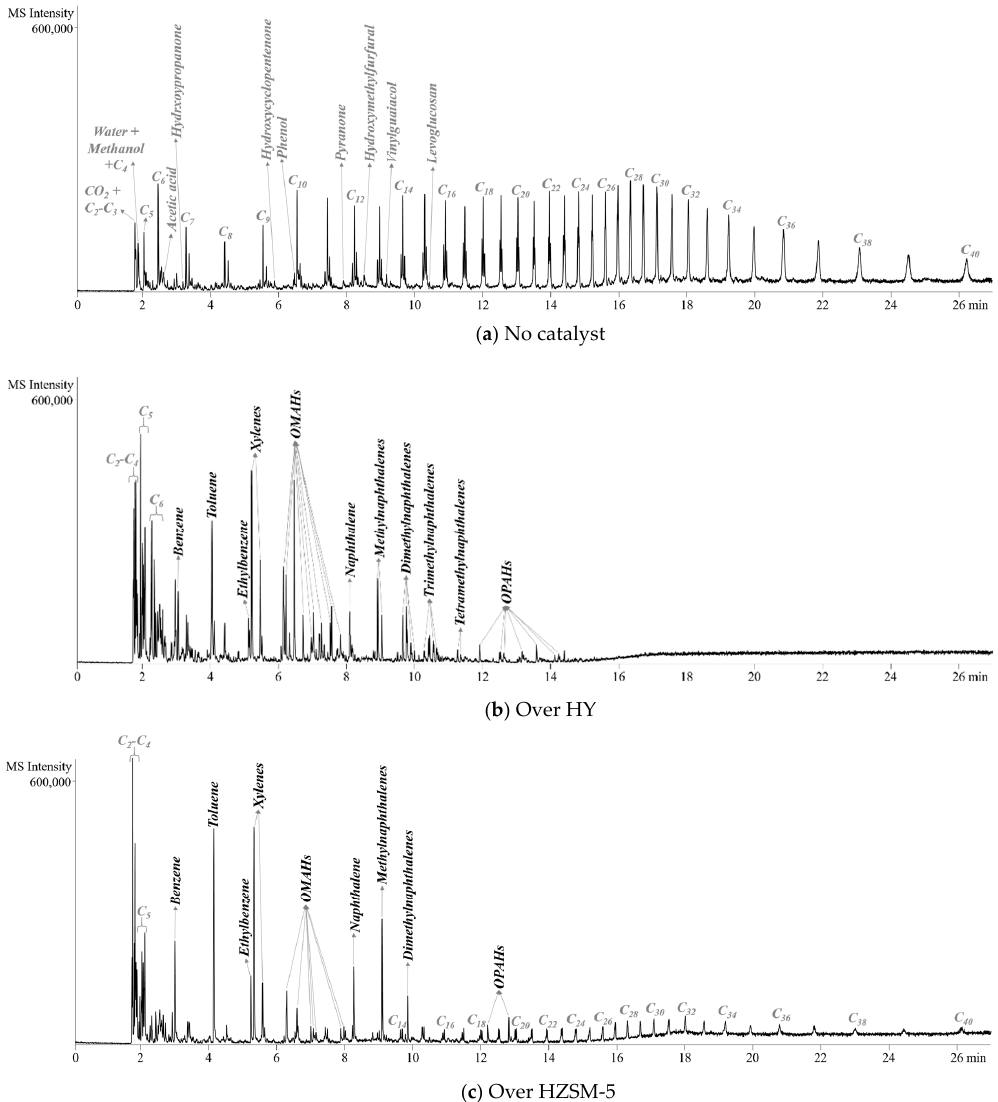
Figure 6. MS chromatograms obtained from the non-catalytic co-fast pyrolysis (NCCFP) and CCFP of MP/HDPE mixture over HY and HZSM-5 at 600 °C.